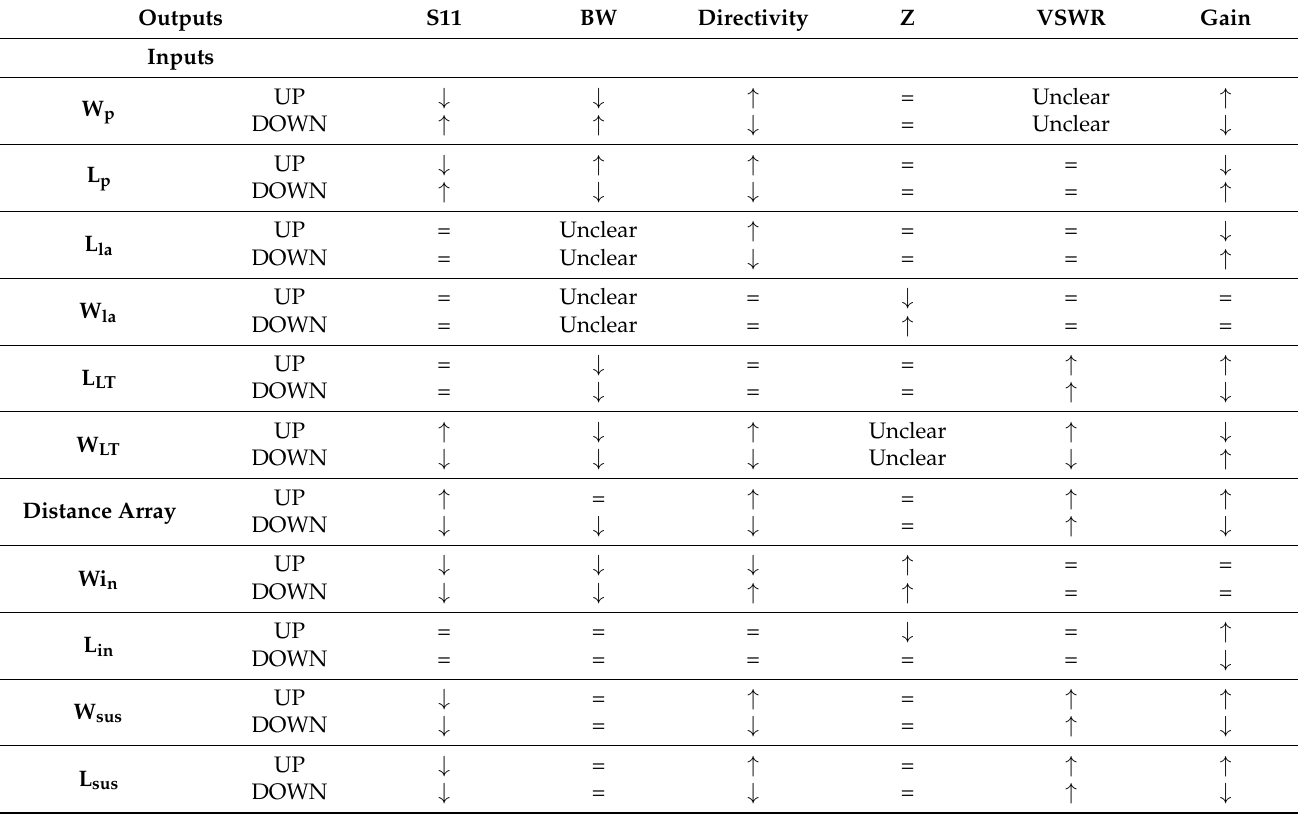
Table 10. Result of the study of simulating the λ /4 antenna with different input parameters.